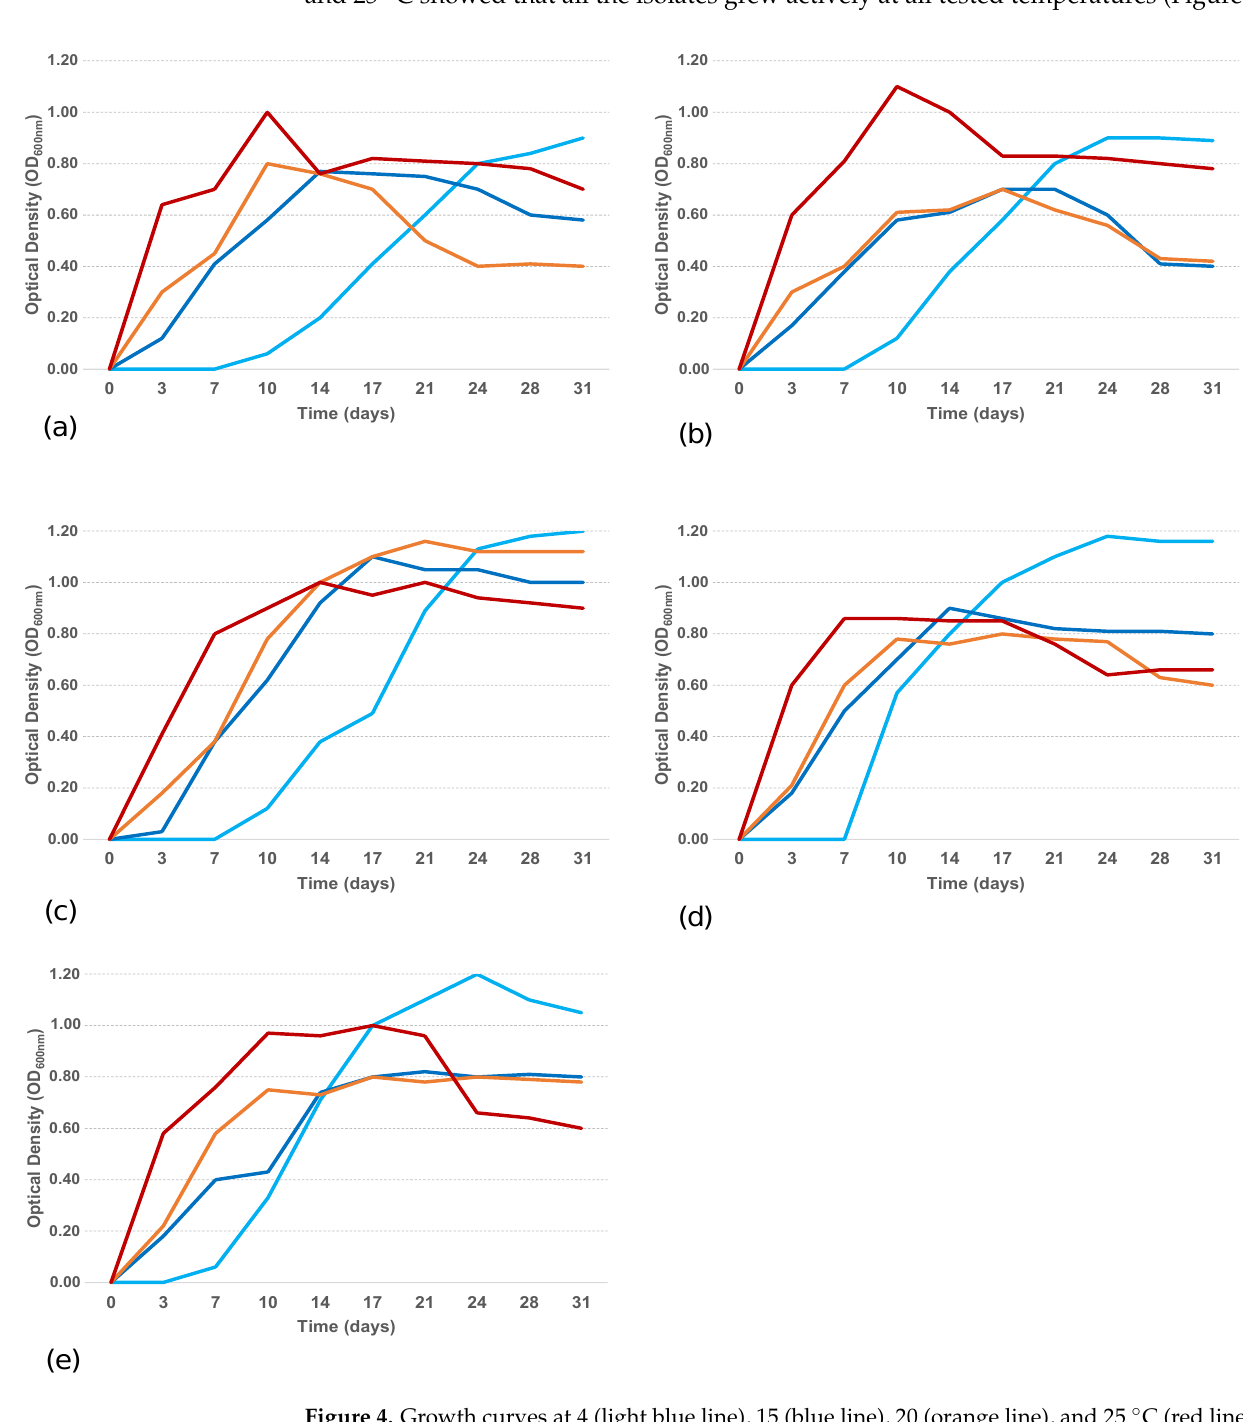
Figure 4. Growth curves at 4 (light blue line), 15 (blue line), 20 (orange line), and 25 °C (red line) for a/ANT5a ( a ), b/ANT6 ( b ), b/ANT8 ( c ), b/ANT10 ( d ), b/ANT11 ( e ) Alcanivorax strains in ONR7a medium amended with sodium acetate (1 % w / v ).